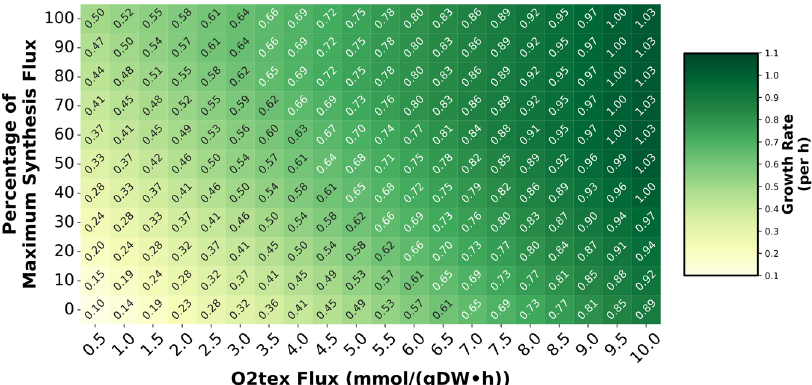
Fig. 3 The limed-FBA model can predict the biomass production dependence on pyocyanin biosynthesis and oxygen availability. Simulations were performed over a wide range of oxygen uptake (from extracellular to periplasm) and pyocyanin biosynthesis fl ux constraints (relative scale shown as percentage such that 100% refers to the highest fl ux computed at 0.5 mmol gDW − 1 h − 1 oxygen import fl ux) by optimizing for biomass production. Each cell refers to the growth rate computed by simulating the model at fi xed oxygen uptake (reaction: O2tex) rate and pyocyanin synthesis fl ux. The color scheme represents increasing growth rates from light yellow to dark green. For oxygen-limited condition (lower oxygen import fl ux), the effect of pyocyanin production on the growth rate is more profound compared to that in more oxygen-rich condition (higher oxygen import fl ux).